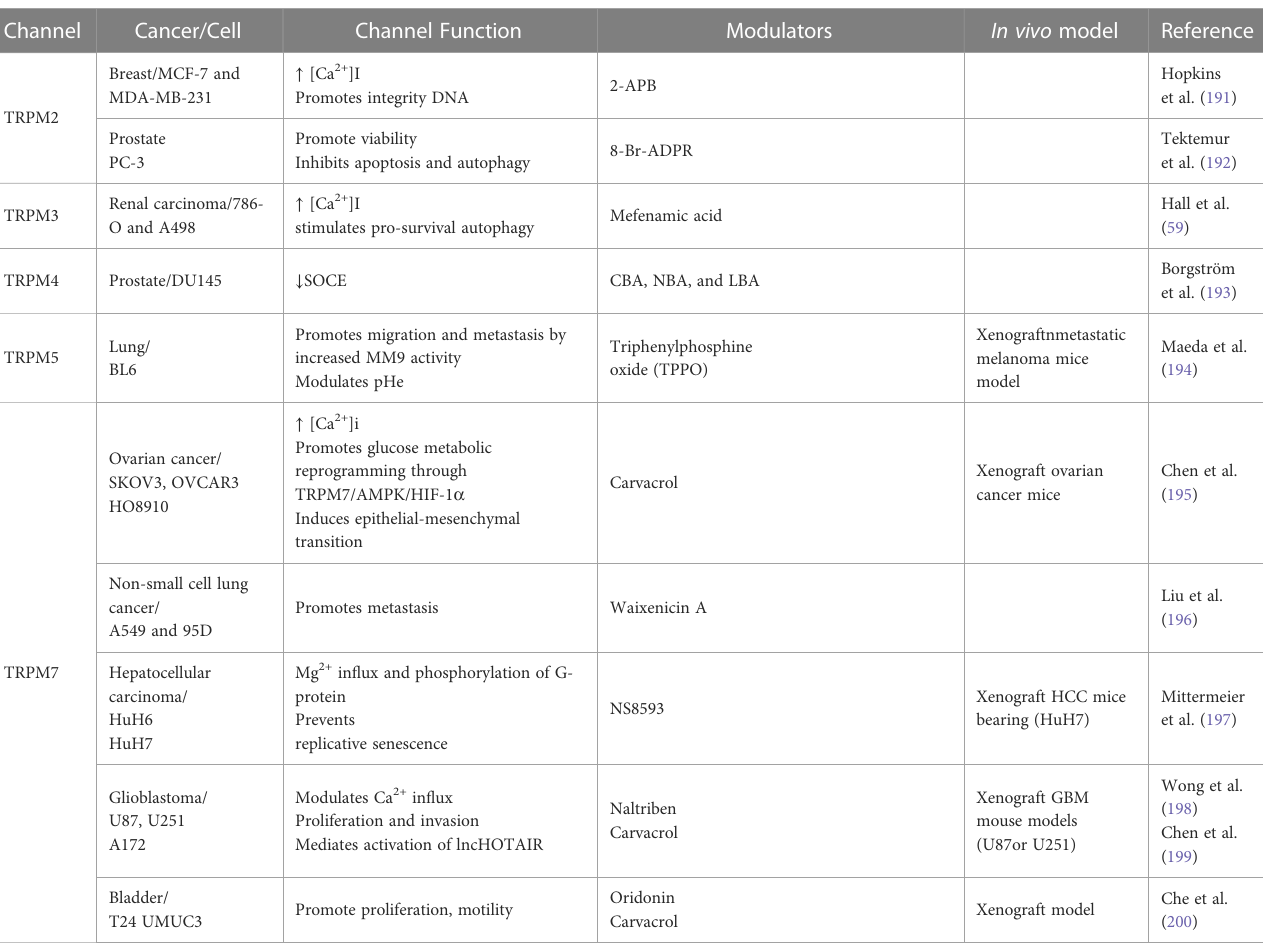
TABLE 1 TRPM functions and their pharmacological modulators in cancer